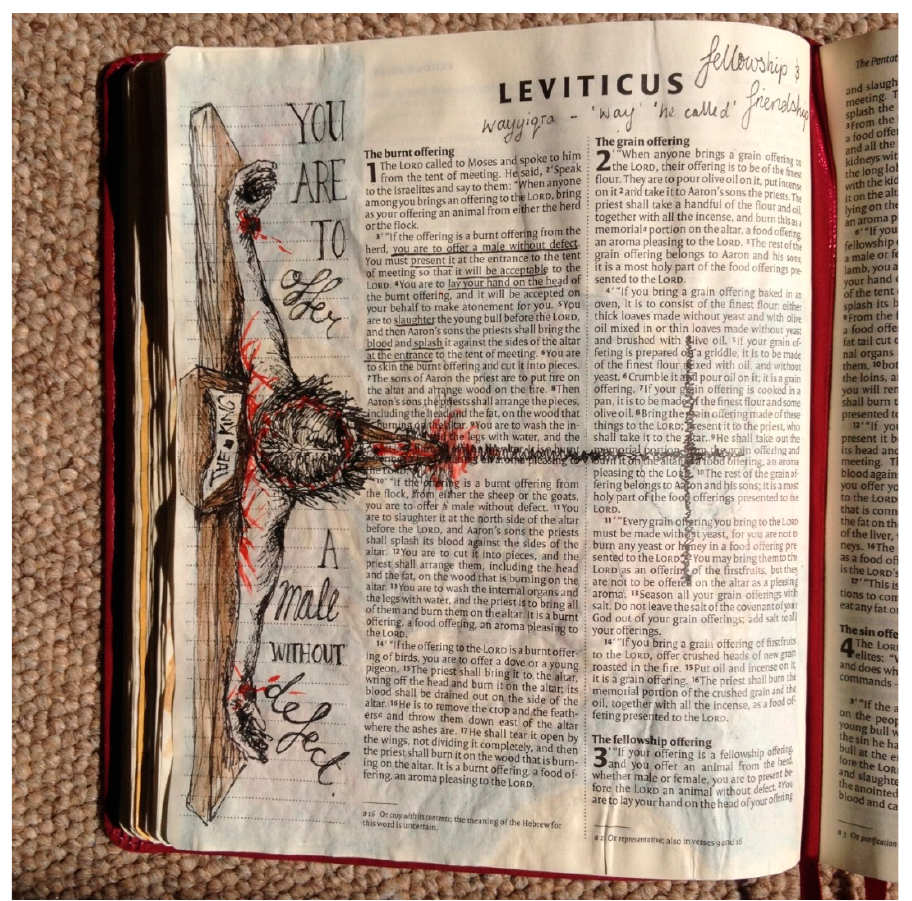
Figure 9. “Without Defect” (2017), Katy Hollway (with kind permission of the journaler). Figure 9. “ Without Defect ” (2017), Katy Hollway (with kind permission of the journaler). Funding: The research conducted in this publication was funded by the Irish Research Council under grant number 21/PATH-A/9461. grant number